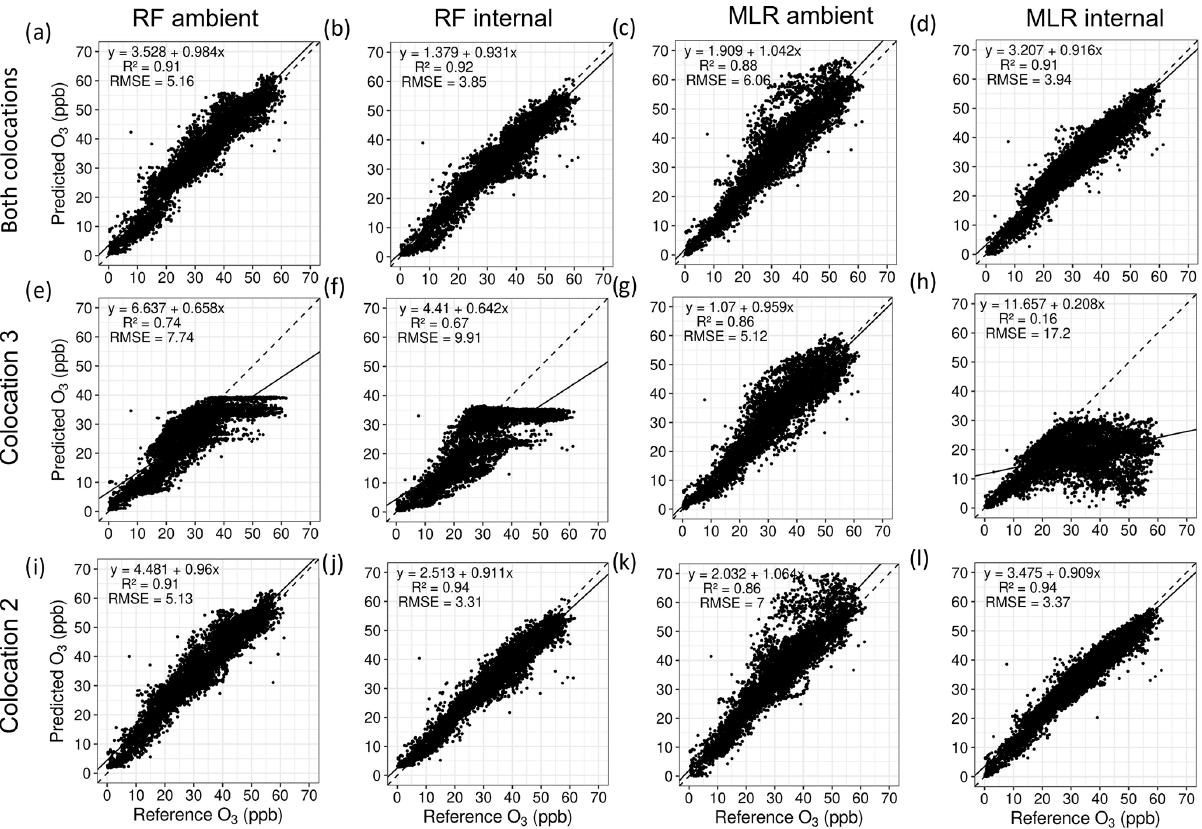
Figure 15. Scatter plots of predicted O 3 versus reference O 3 concentrations for the experimental data using MLR and RF models trained with co-location 2 (i–l) , co-location 3 (e–h) , and both combined (a–d) . All concentrations are reported in parts per